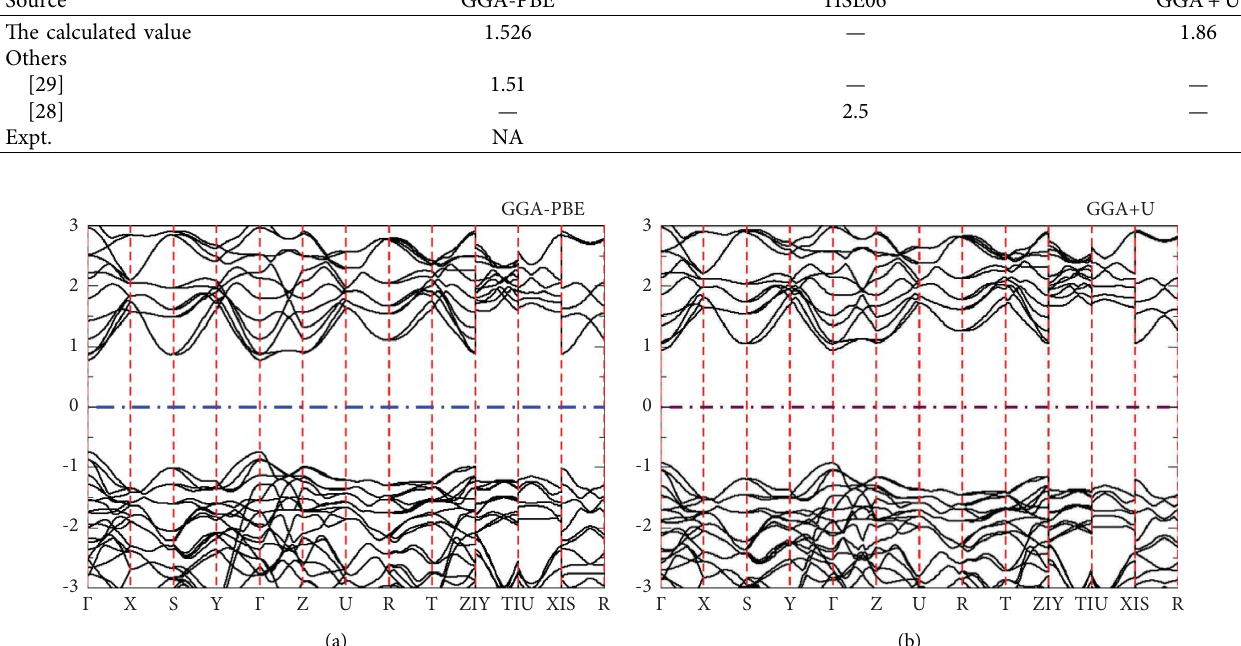
Table 5: Calculated band gap value (eV) of CaHfS Source Te calculated value